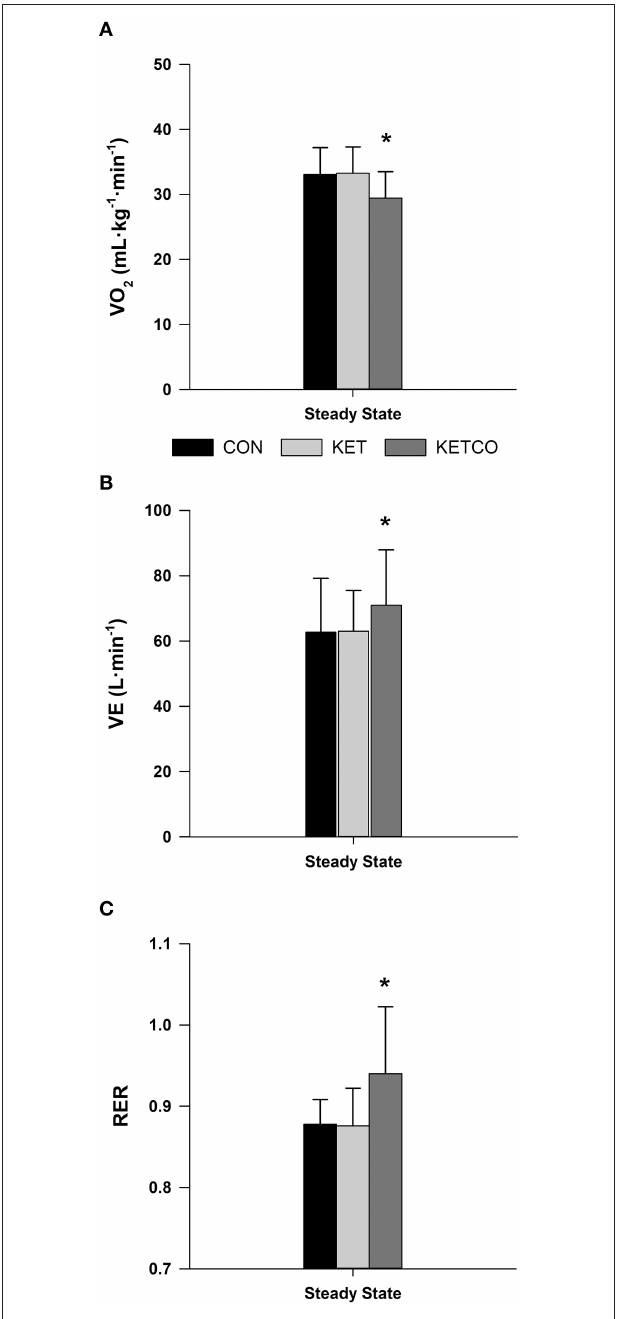
FIGURE 3 | (A) Mean oxygen consumption, (B) mean minute ventilation, and (C) mean respiratory exchange ratio during steady state exercise for each experimental condition. *Significantly different from CON and KET